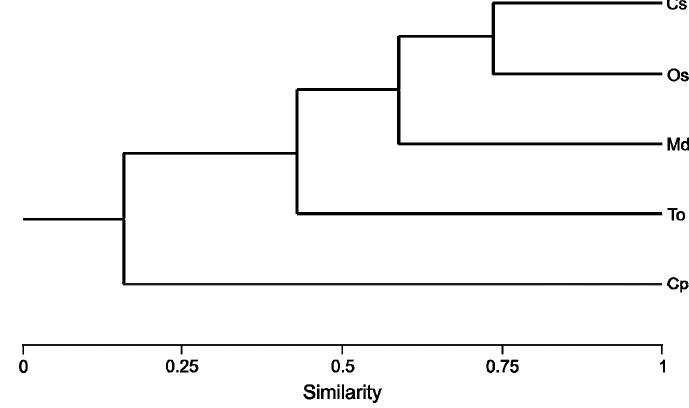
Fig. 4 – Similarity of the temporal distribution among five of the six lizards species studied in the studied area, Rio Grande do Sul, Brazil. Cophenetic Correlation Coefficient: r = 0.91. Cs = Cercosaura schreibersii ; Os = Ophiodes striatus ; Md = Mabuya dorsivittata ; To = Teius oculatus ; Cp = Cercosaura ocellata petersi .